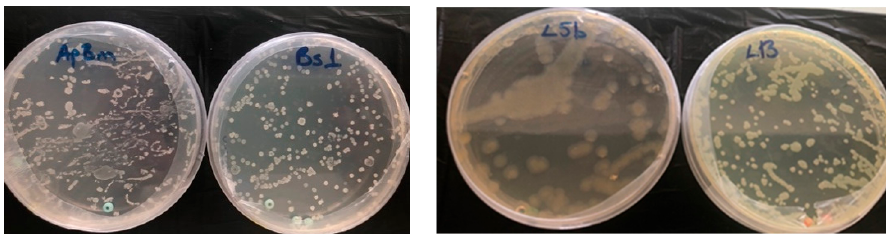
Figure 3. Pure cultures of the endophytic bacteria on King B medium.